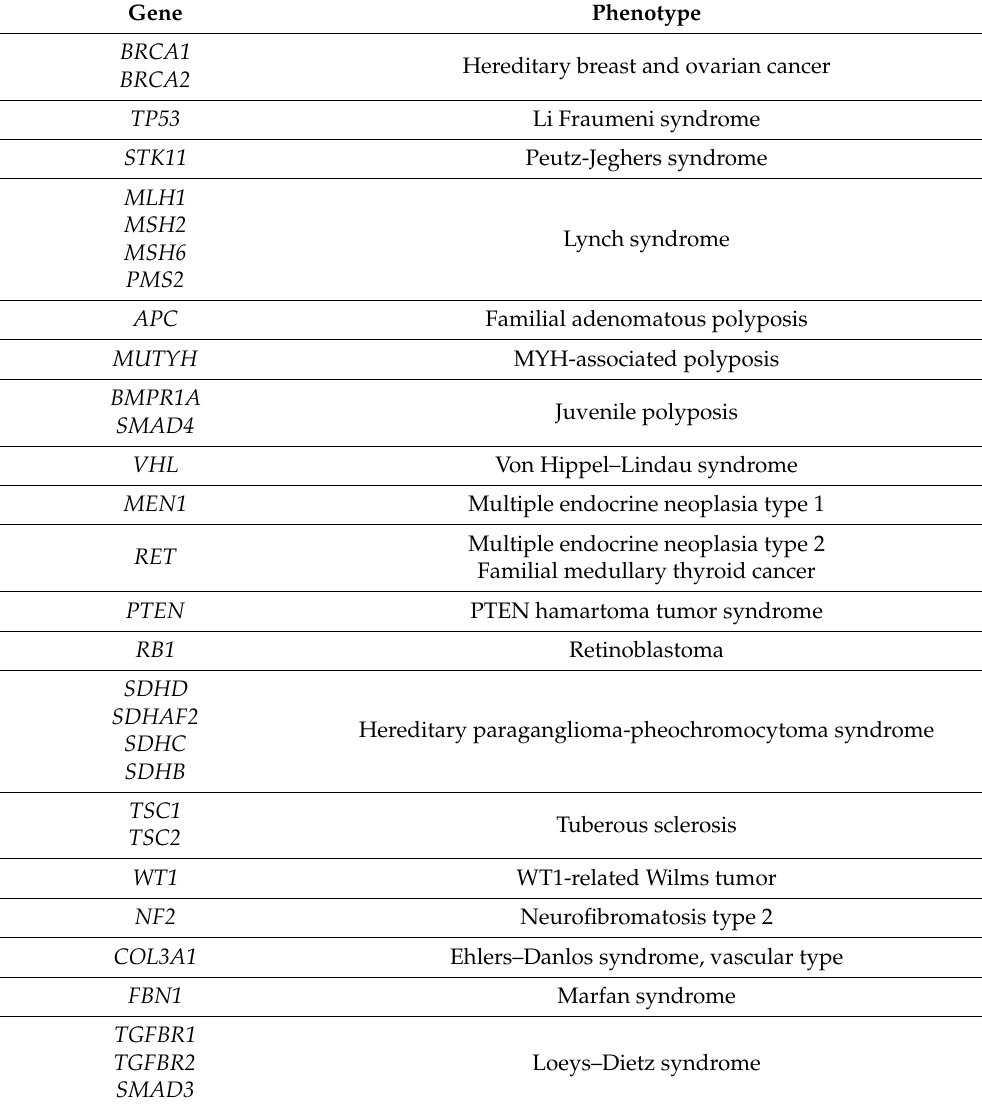
Table A2. American College of Medical Genetics and Genomics (ACMG) Secondary Findings v2.0 genes and associated phenotypes